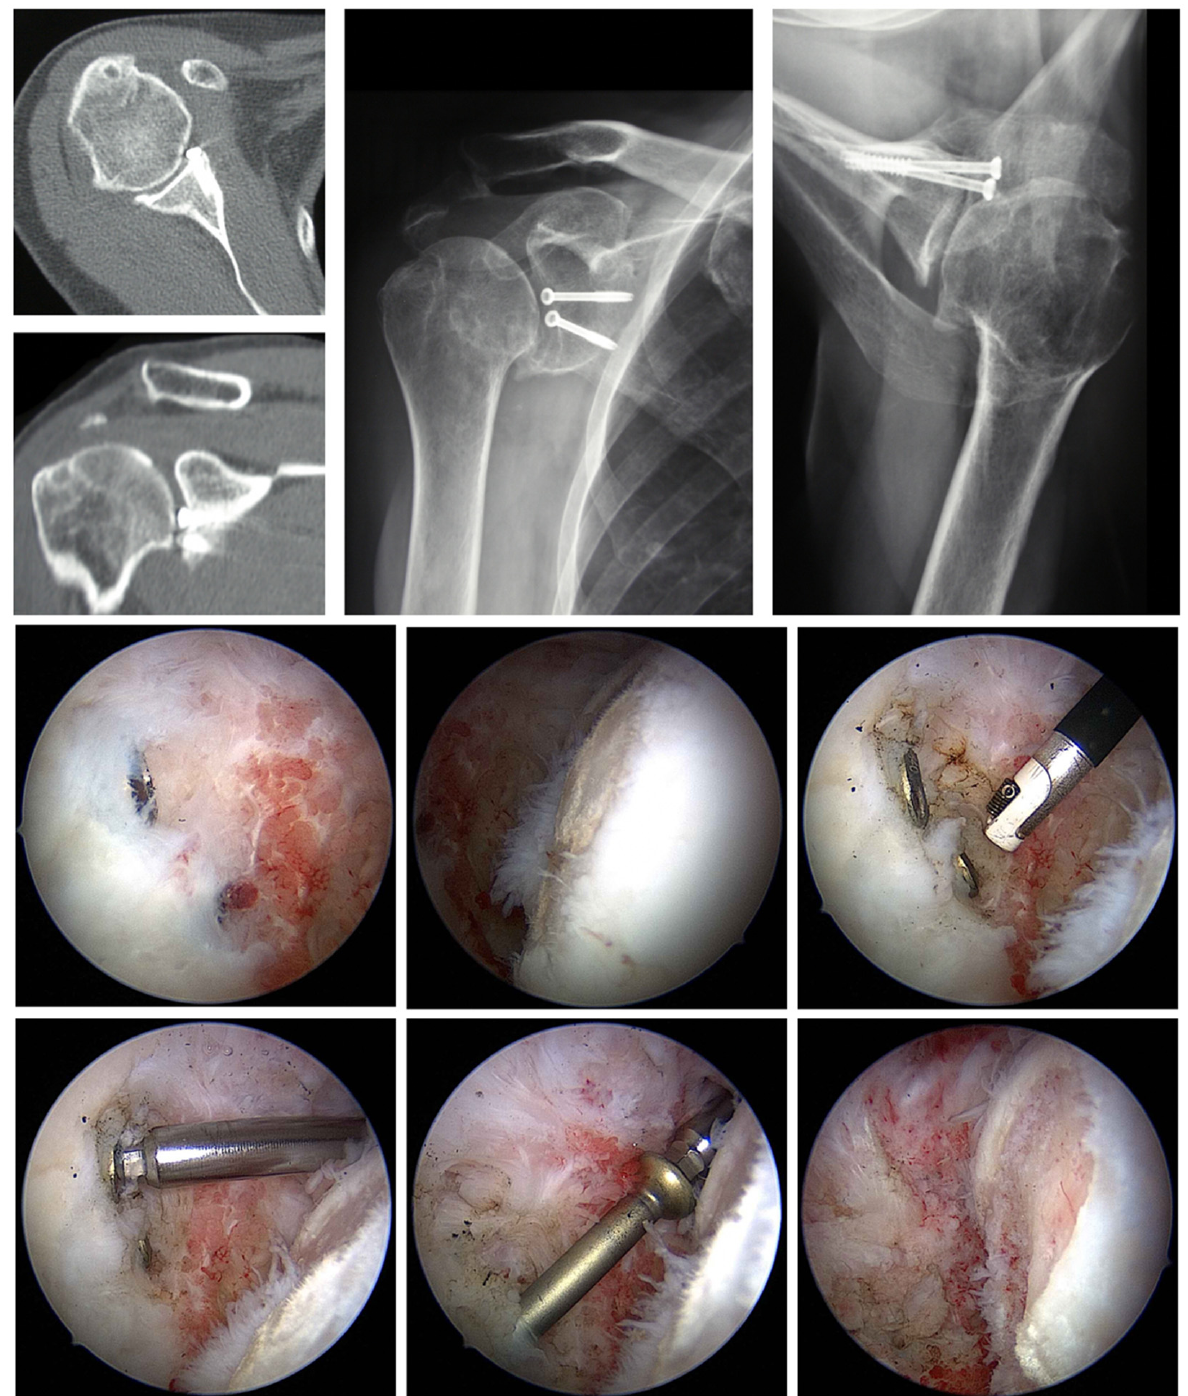
Figure 3. Details of proud screws after glenoid fracture surgery removed arthroscopically. First row : radiologic studies showing instability surgery performed and proud implants. Second row : Images of a humeral cartilage defect and debridement necessary to expose implants. Third row : Arthroscopic screws removal.